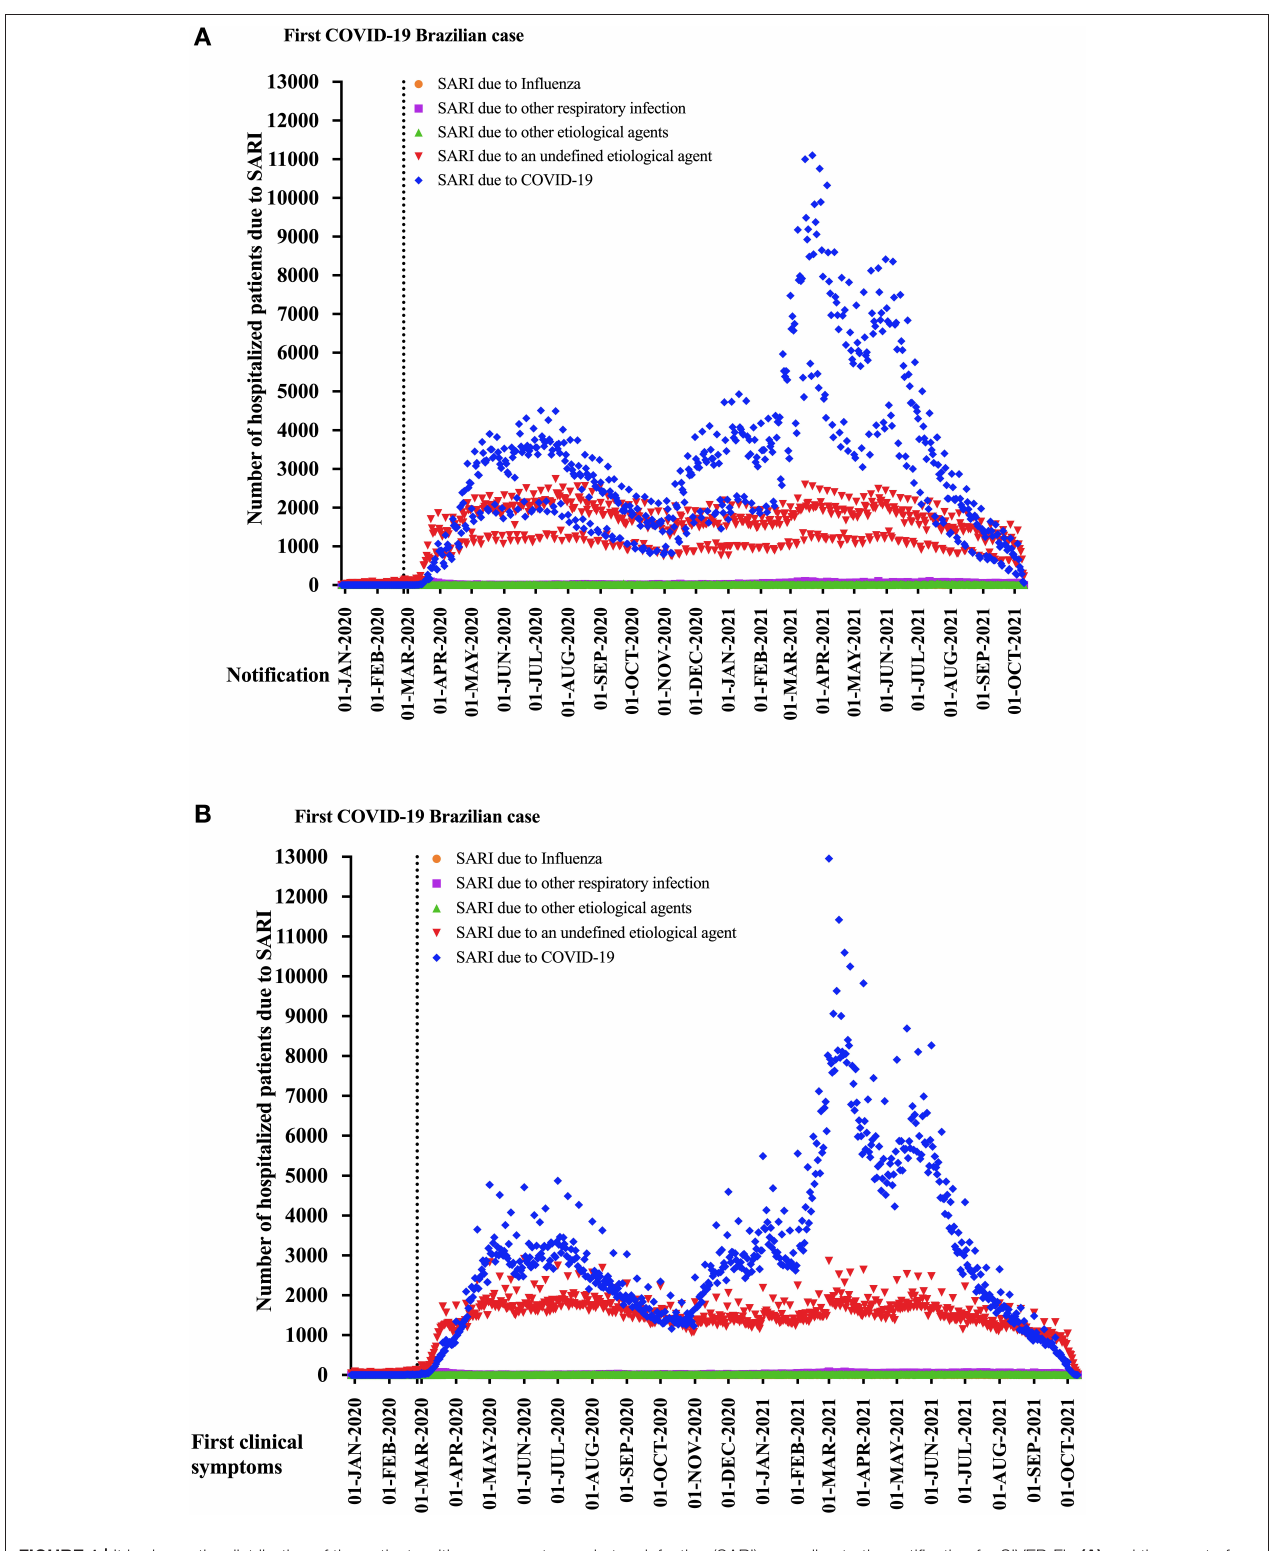
FIGURE 1 | It is shown the distribution of the patients with severe acute respiratory infection (SARI) according to the notification for SIVEP-Flu (A) and the onset of clinical symptoms (B) . We presented the data according to the SARI categories, which evidenced the increase of the number of COVID-19, as well as the rise of SARI due to an undefined etiological agent among the Brazilian patients after the description of the first positive individual with SARS-CoV-2 infection at São Paulo state.